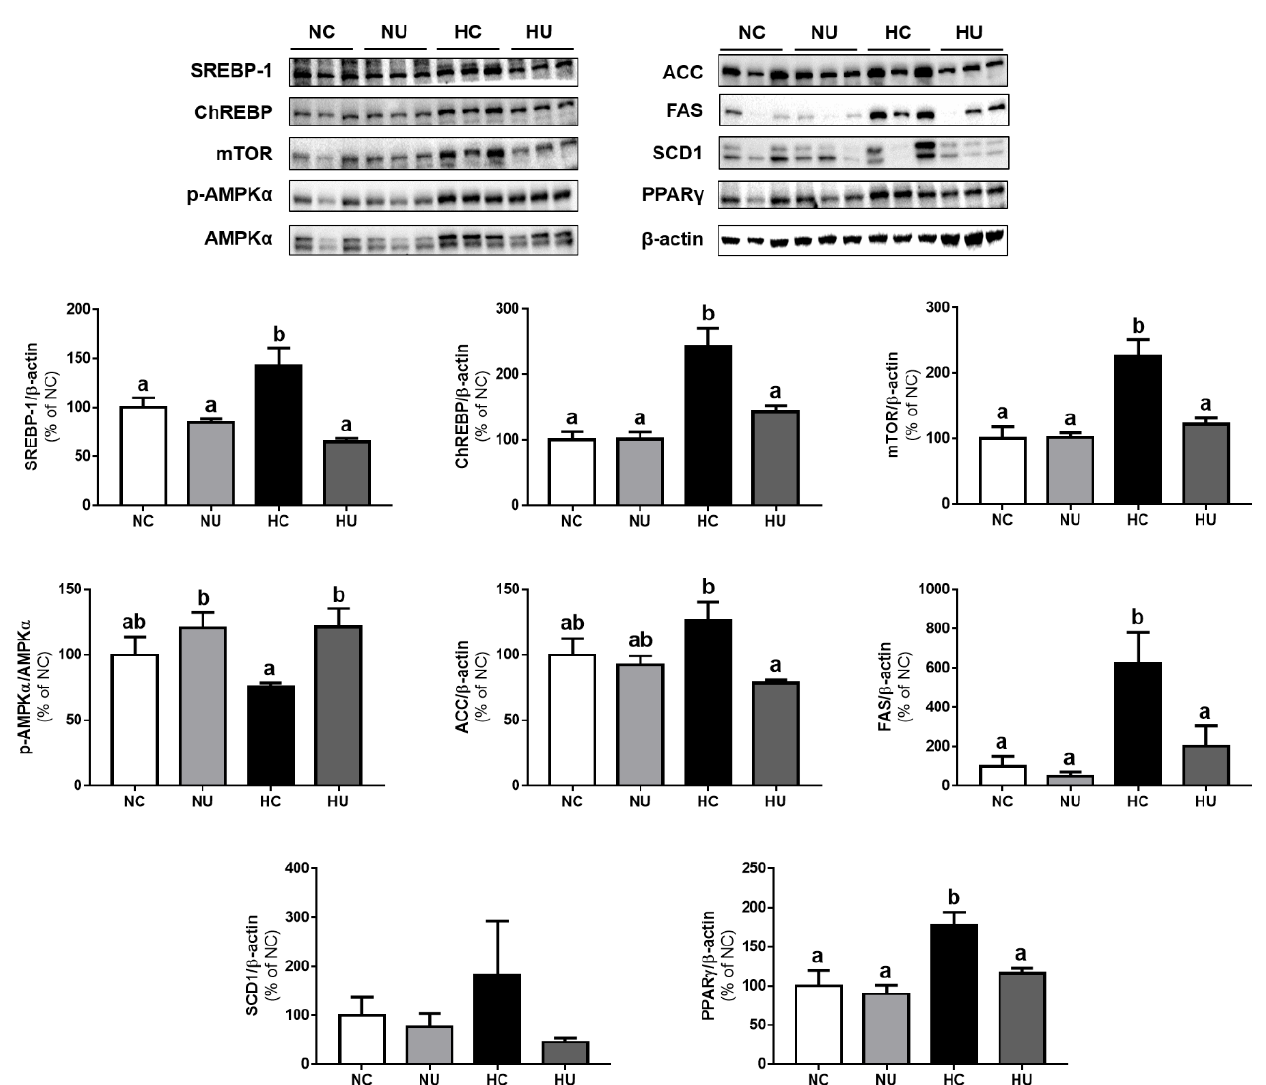
Figure 5. Effects of Bacteroides uniformis CBA7346 treatment on expression of lipid metabolism related proteins in liver tissues of mice with high-fat diet-induced non-alcoholic fatty liver disease; Western blot analysis of SREBP-1, ChREBP, mTOR, p-AMPK α , AMPK α , ACC, FAS, SCD1, and PPAR γ in the liver. NC, control group on normal diet; NU, group on normal diet receiving 1 × 10 6 CFU B. uniformis CBA7346 thrice a week; HC, control group on high-fat diet; HU, group on high-fat diet receiving 1 × 10 6 CFU B. uniformis CBA7346 thrice a week. Data are presented as mean ± SEM ( n = 3). Means with different letters (a,b) indicate significant difference ( p < 0.05). Groups were compared using Duncan’s multiple range